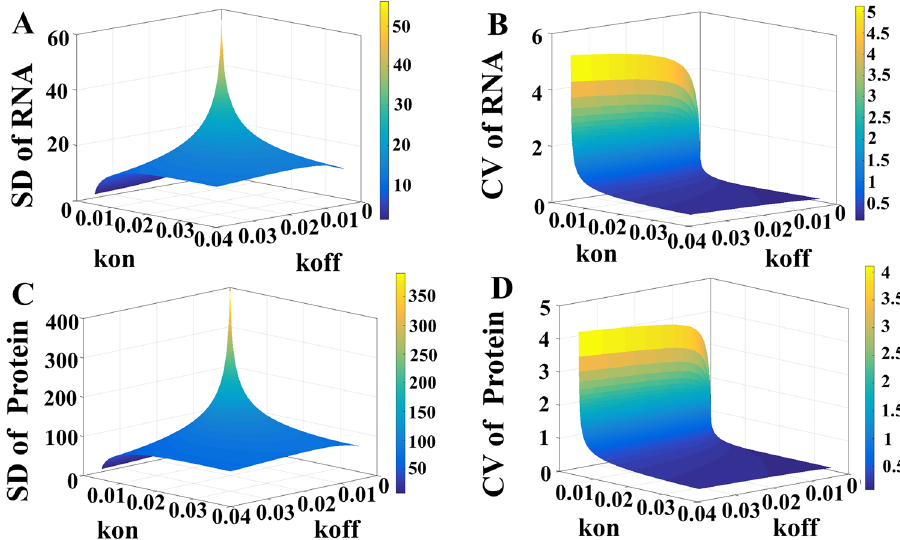
Figure 6. The SD and CV of RNA and protein with different values of k on and k off . The rate constant k off describes the switch of DNA from the ON to the OFF state and k on is from the OFF to the ON states. ( A , B ) are the SD and CV of RNA, respectively. The SD and CV of protein are ( C , D ),